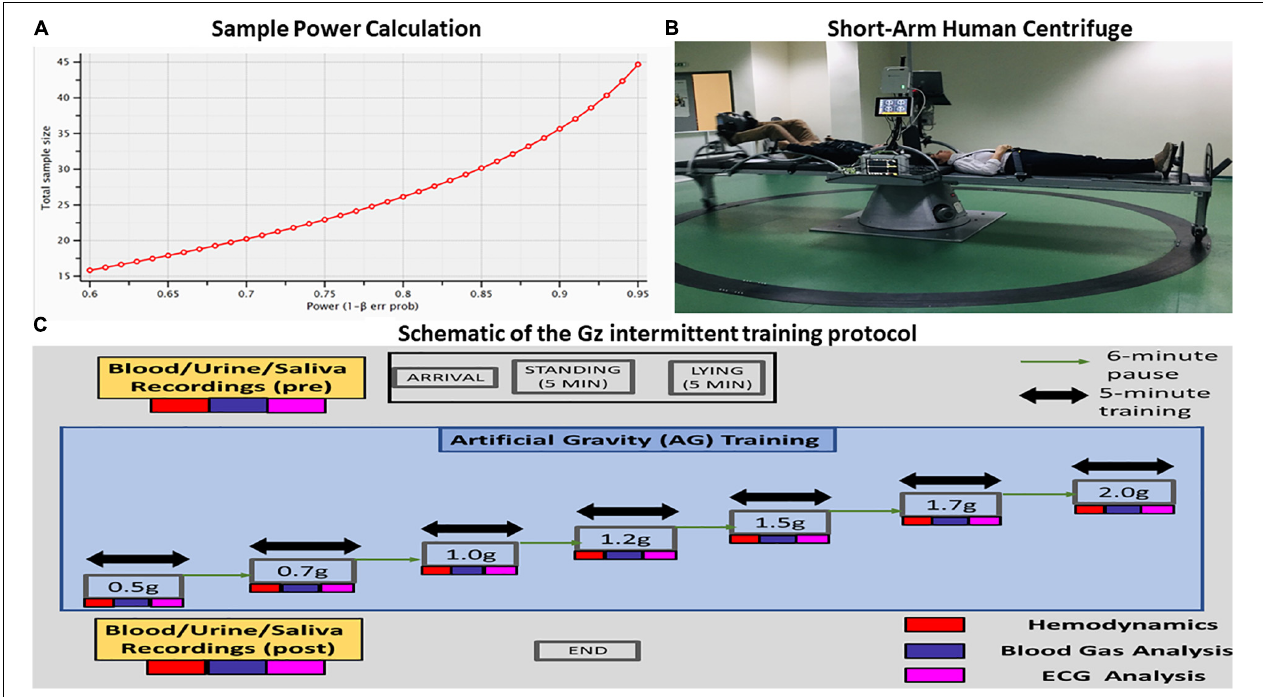
FIGURE 1 | (A) Visualization of the analysis performed for estimating the proper sample size for the proposed statistical analysis. The power analysis indicated that the proper sample size differed between parametric (28) and nonparametric tests (27). (B) Visualization of the short-arm human centrifuge with two rotating beds. Each bed is equipped with either aerobic or resistance training. There is also the feasibility of artificial gravity (AG) training with no exercise at all in the case of patients suffering from severe mobility difficulties. Cardiovascular biomarkers are monitored in real time, providing thus indices of the exercise intensity and alerts in case of critical situations. Multi-modal neurophysiological analysis during the exercise is being performed through a portable Nihon Kohden EEG device with 32 electrodes mapping electroencephalography (EEG), electrocardiography (ECG), electromyography (EMG) and electro-oculogrammic (EOG) activity. (C) Schematic of the + Gz intermittent training protocol. Each phase is labeled accordingly, indicating the corresponding + Gz load over time in minutes.